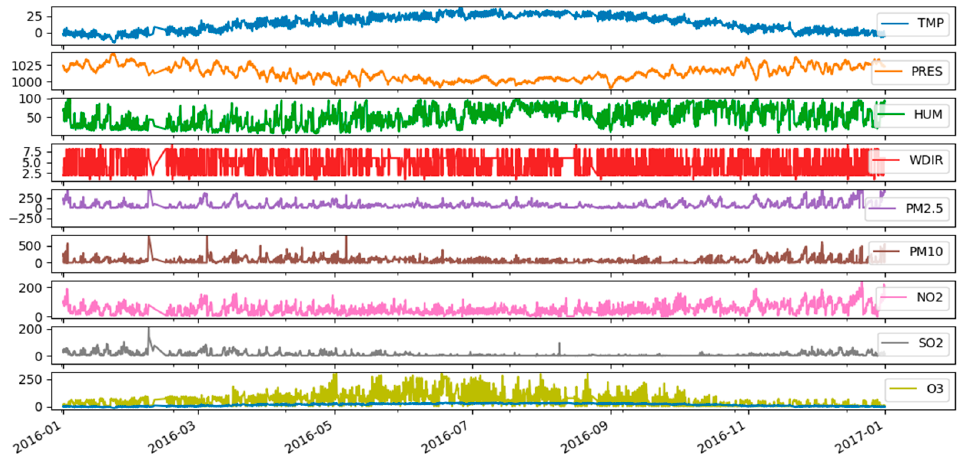
Figure 4. Time-series characteristics of PM2.5 concentrations at different times for each feature.